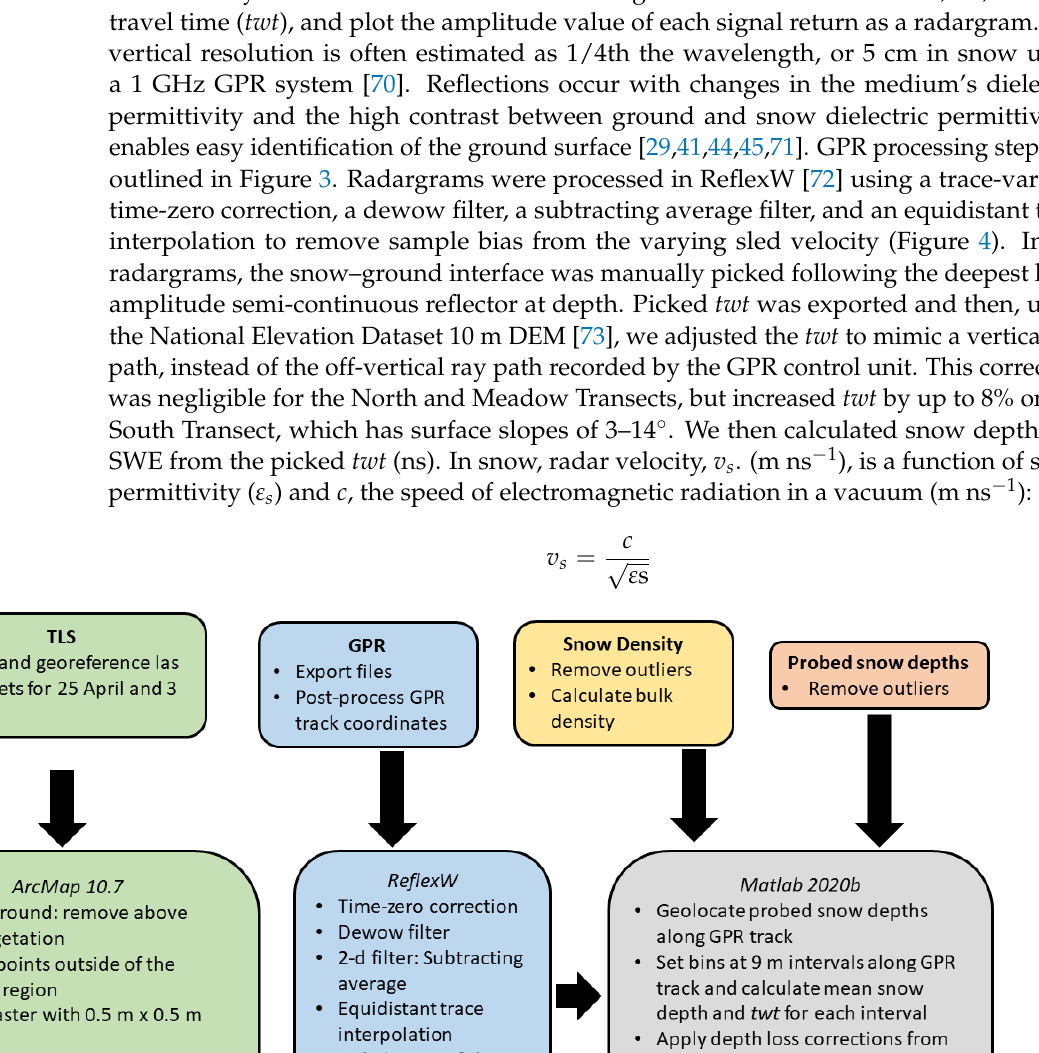
Figure 4. Processed radargram from the midday North Transect survey on 19 June 2019. The bright white reflector, that varies from 4 to 7 ns depth was identified as the snow–ground interface, as the reflector’s brightness indicates a large shift in permittivity. We picked this continuous reflector, as is noted by the red line. Depth was calculated using a radar velocity of 0.14 m ns −1 . 3.5. TLS Processing We used repeat terrestrial laser scanning (TLS) surveys of the Meadow and South Transects to measure snow ablation that occurred during the 25 April and 3 June survey dates. TLS surveys were acquired using a Riegl VZ-6000 from 10:00 to 11:00 MDT and 14:00 to 15:00 MDT on 25 April and 3 June. We processed the TLS datasets following a methodology similar to Deems et al. [74]; these steps are outlined in Figure 3. Scans were aligned and georeferenced to the NAD 1983 UTM Projected Coordinate System (EPSG:26913) and a surface classification was completed in ArcMap 10.7 to remove above- snow vegetation from the point cloud, using a surface classification algorithm. The re- maining points were rasterized at 0.5 m resolution. We then differenced the lidar-derived digital surface models (DSMs) acquired from 10:00 to 11:00 MDT and those from 14:00 to 15:00 MDT to produce distributed fields of snow depth loss/ablation during a single field day. Erroneous depth loss values, identified as increases in snow depth or decreases in snow depth by >0.05 m, were caused by a scanning position that shifted due to an unstable